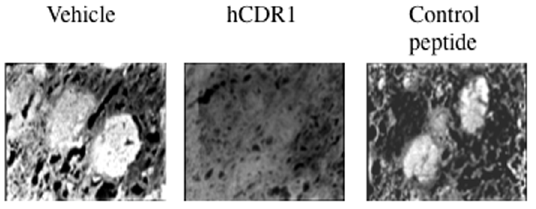
Figure 2. hCDR1 down regulates immune complex deposits in kidney sections. Immunohistology of kidney sections of representa- tive mice of each experimental group (vehicle, hCDR1 and control peptide treated mice). Magnification X400.